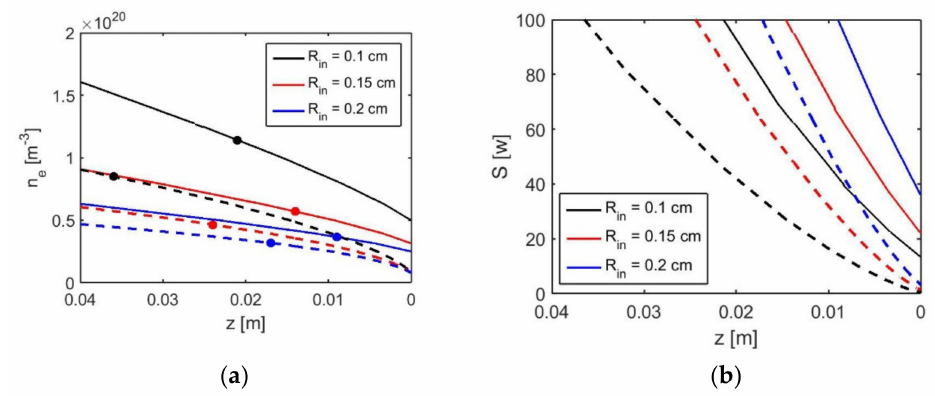
Figure 5. Theoretical axial distribution for three discharge tubes with different internal radii of ( a ) plasma density; ( b ) wave power. The solid lines correspond to plasma inside dielectric tube and the dashed lines are for plasma torch (plasma surrounded by